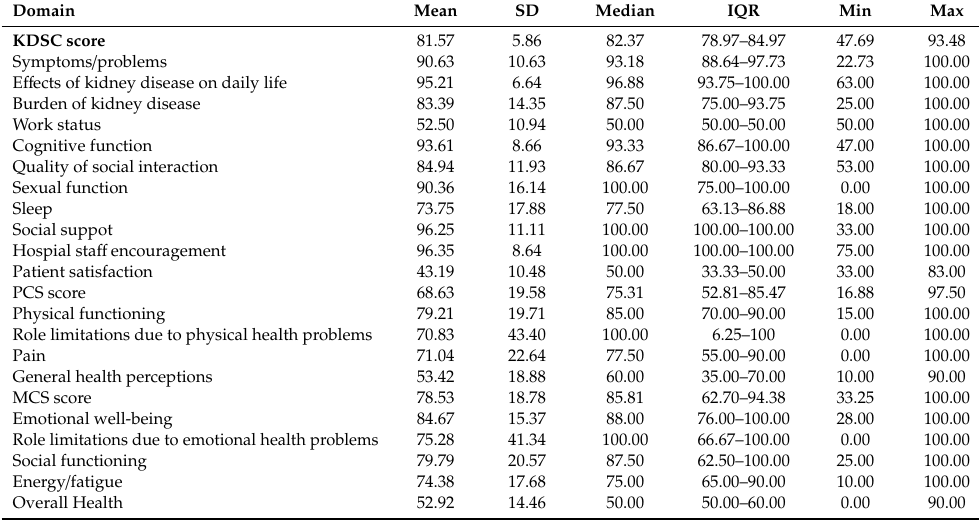
Table 4. Mean PCS was lower compared to mean scores for MCS and KDSC. Table 4. Mean and dispersion for Kidney Disease Quality of Life-SF domain